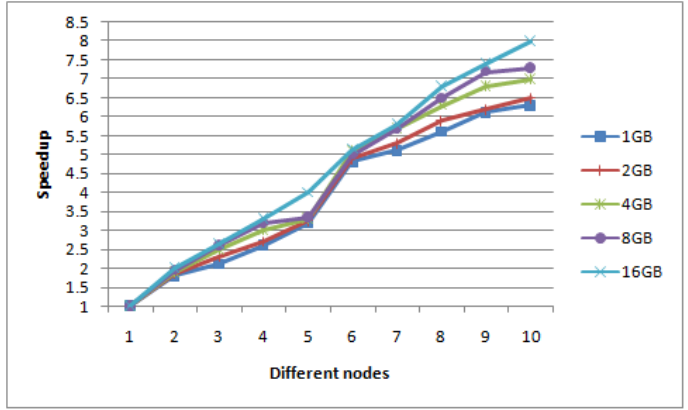
Figure 11. Speedup ratio in five groups of different size image